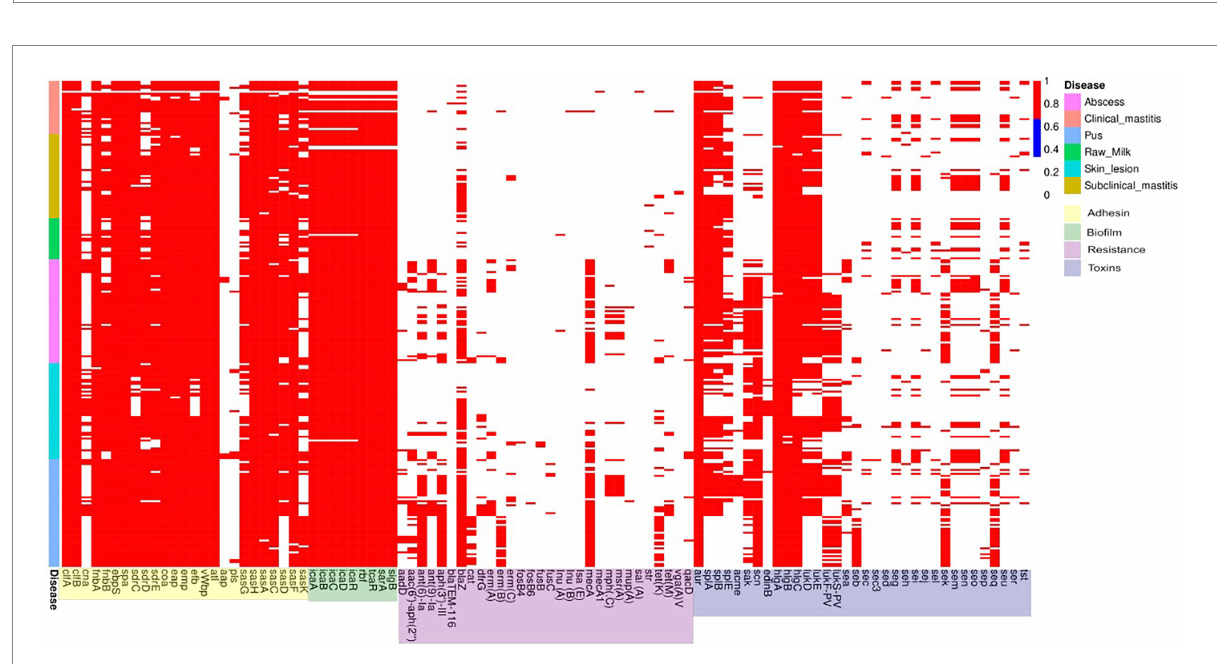
FIGURE 4 Binary frequency graph of adhesion, biofilm, antimicrobial resistance, and toxin gene frequencies in S. aureus from clinical and subclinical bovine mastitis cases and raw milk, and from human abscesses, skin infections, and